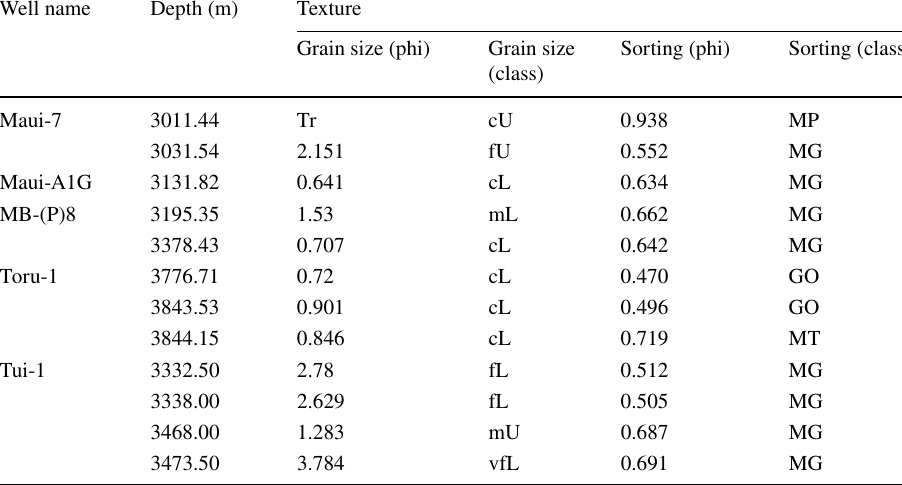
Table 2 Textural figures of the selected wells of the Kaimiro